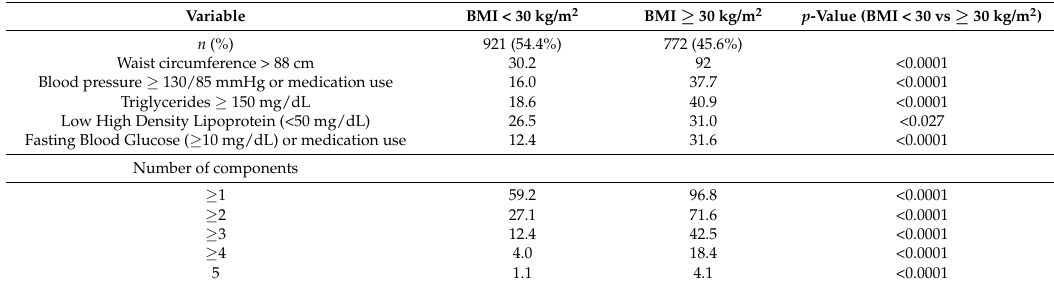
Table 3. The relative frequencies of the individual components of the metabolic syndrome and the number of MetS components present in refugee women by body mass index